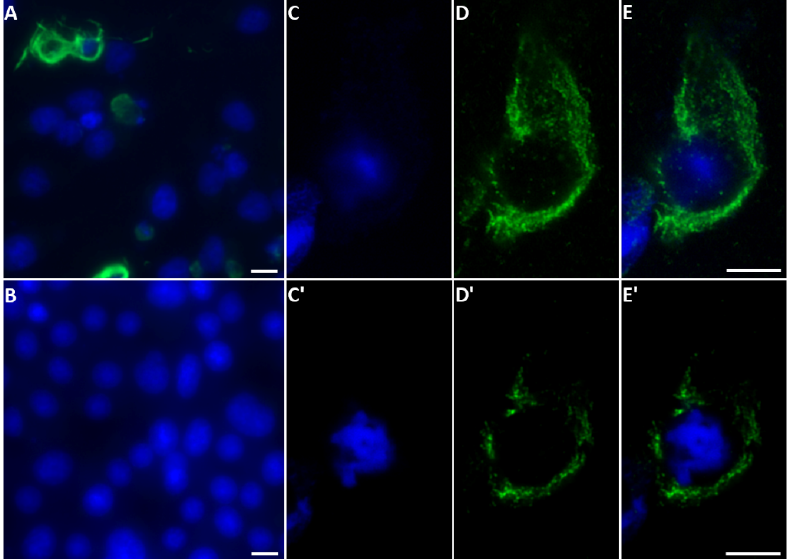
Figure 8. Detection of NS5 in KEMV-infected BSR cells by fl uorescence microscopy: Nuclei were stained with DAPI and probed with mouse anti-KEMV NS5 antibodies and Alexa Fluor 488-conjugated anti-mouse IgG. Epifluorescence microscopy of immunofluorescence microscopy of KEMV-infected ( A ) and non-infected ( B ) BSR cells, using anti-NS5 KEMV antibodies. NS5 is mainly identified in the cytoplasm of BSR cells infected with KEMV. Confocal immunofluorescence microscopy of KEMV-infected BSR cells using anti-NS5 anti-sera ( C – E and C ′ – E ′ ). Two focal planes of the same cell are shown. ( C , C ′ ) show the nuclei coloured by DAPI. ( D , D ′ ) show the detection of NS5 (green fluorescence). ( E , E (cid:48) ) show a merge of the ( C , C (cid:48) ) and ( D , D (cid:48) ) panels. The scale bar represents 5 µ